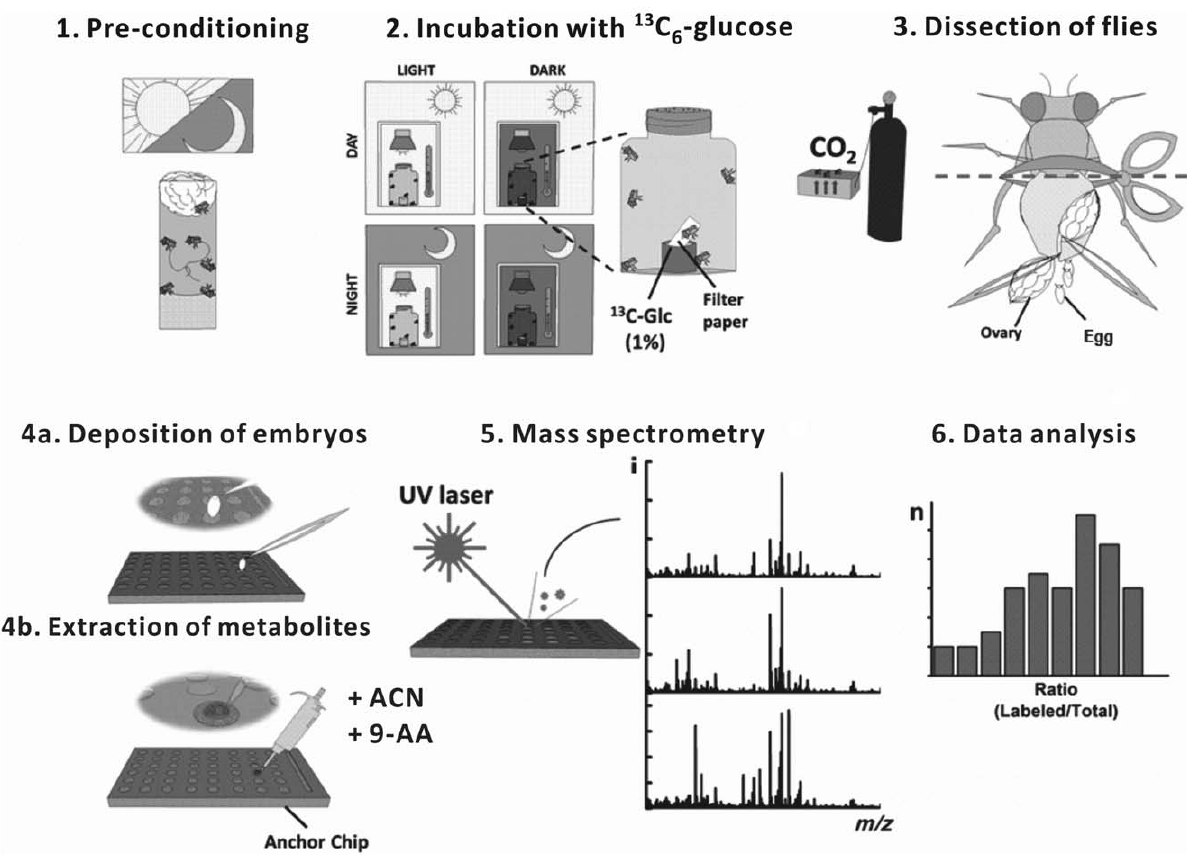
Figure 1. Experimental design and chemical analysis workflow. (1) pre-conditioning (entrainment) of the culture stock (adaptation to the 12/ 12-h (light/dark) cycle); (2) incubation of female fruit flies with 13 C 6 -glucose solution; (3) dissection of the anesthetized flies; (4a/4b) preparation of individual eggs for mass spectrometric analysis; (5) mass spectrometry, and (6) data analysis.